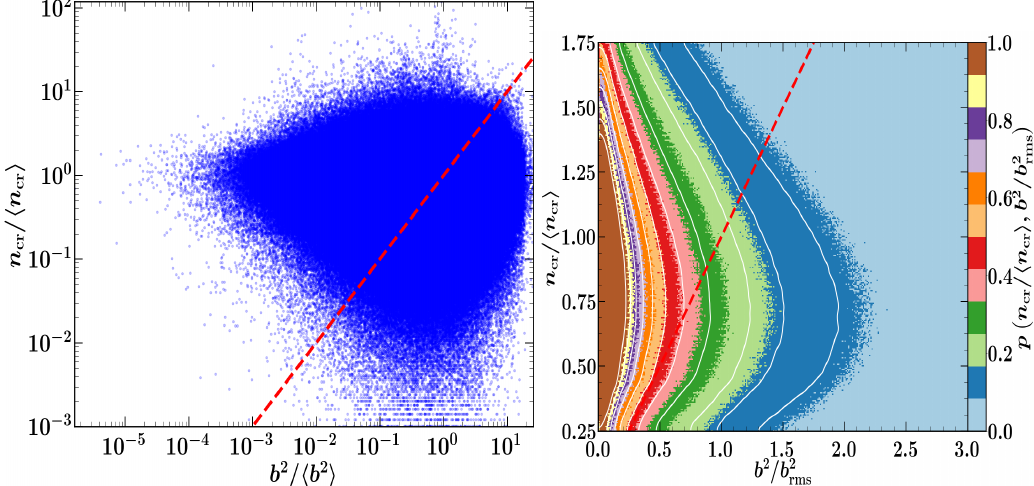
Figure 6. Left panel: Scatter plot for the normalized number density of cosmic rays n cr / (cid:104) n cr (cid:105) and magnetic fields’ energy density b 2 / (cid:104) b 2 (cid:105) . Right panel: Joint PDF (probability distribution function) of n cr / (cid:104) n cr (cid:105) and b 2 / (cid:104) b 2 (cid:105) with contours showing probability levels [0.1,0.15,0.2,0.3,0.4,0.5,0.6,0.7,0.8,0.9,0.99] for a range in cosmic ray number density ( 0.25 ≤ n cr / (cid:104) n cr (cid:105) ≤ 1.75 ) and magnetic field energy density ( 0.0 ≤ b 2 / (cid:104) b 2 (cid:105) ≤ 3.0 ) where most points ( ≈ 95%) of the left-hand panel lie. The red dashed line shows a one-to-one correlation between the two quantities in both panels. The cloud of points in both panels confirms that the cosmic ray number density and magnetic field energy density are uncorrelated in test-particle